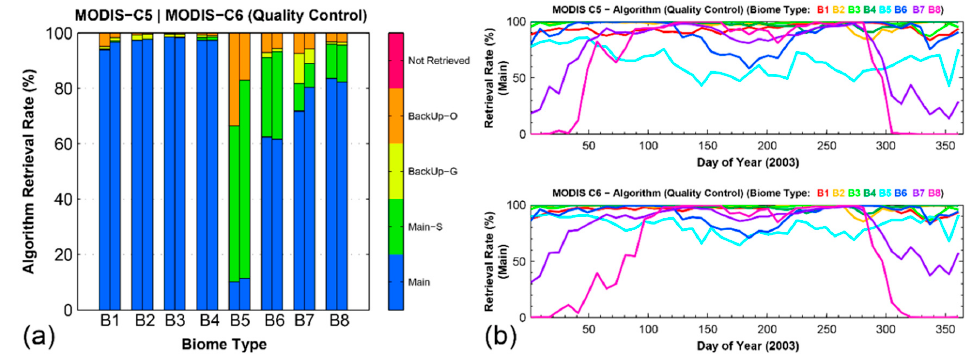
Figure 3. Comparison of global retrieval rate of different algorithm paths (retrieval index) for eight biome types. ( a ) Yearly and globally averaged (in 2003) retrieval rate of different algorithm paths. Possible algorithm paths are (i) Main (Main algorithm without saturation); (ii) Main-S (Main algorithm with saturation); (iii) BackUp-G (Backup algorithm because of bad sun-sensor geometry); (iv) BackUp-O (Backup algorithm because of other reasons) and (v) Not Retrieved (not executed because BRF data are not available). For each biome, the left bar is for C5 and right one is for C6; ( b ) Annual variation of main algorithm spatial coverage in 2003 (upper plot is for C5 and lower plot is for C6). This statistic is done after quality control using cloud and aerosol